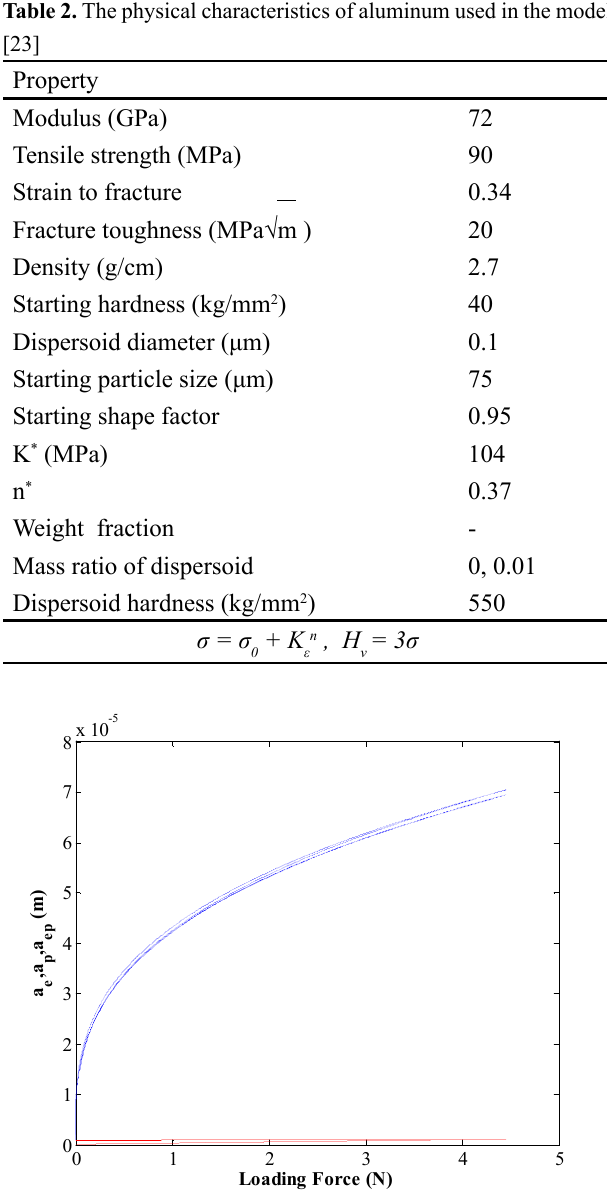
Fig. 3. Elastic, plastic and elastic-plastic radius in term of normal force.